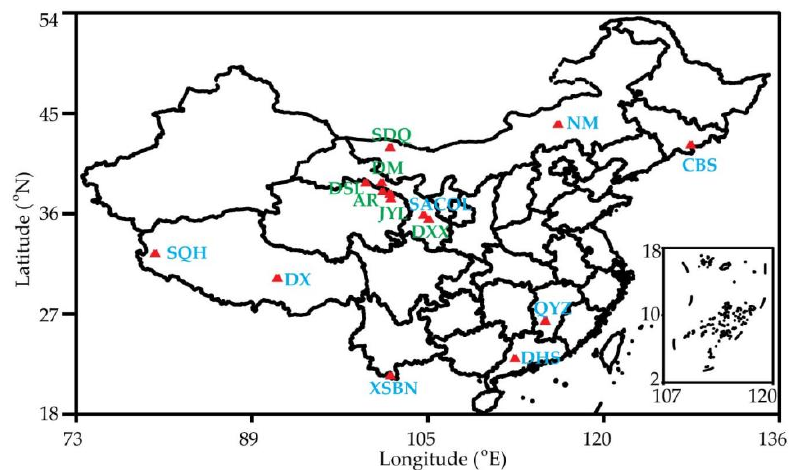
Figure 1. Location of observation sites. The red triangle represents the ground stations, the green font represents the name of the station used to develop the ET retrieval model, and the blue font represents the name of the station used to analyze ET regulation. Table 1. Overview of the observation sites used for developing the ET retrieval model.